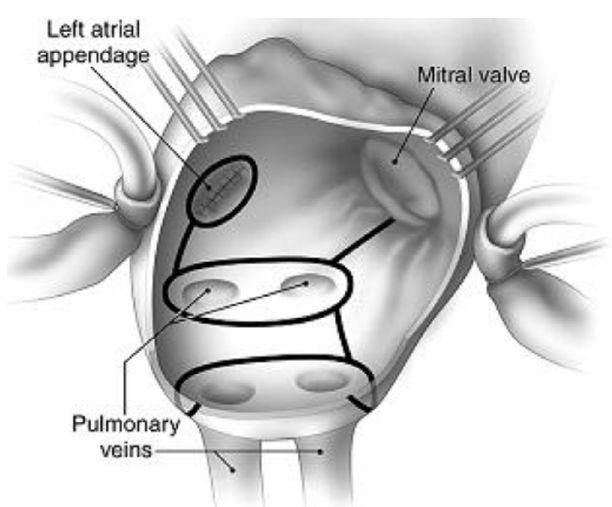
Fig. 1 – Schematic view of cryoablation of Cox-Maze III